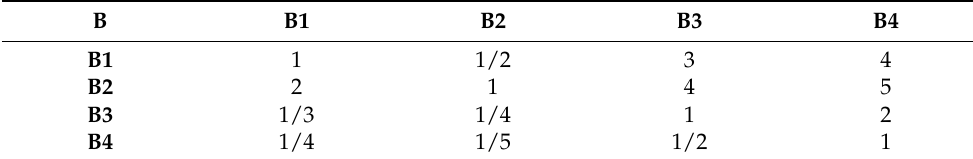
Table 2. The pairwise comparison table of criteria.